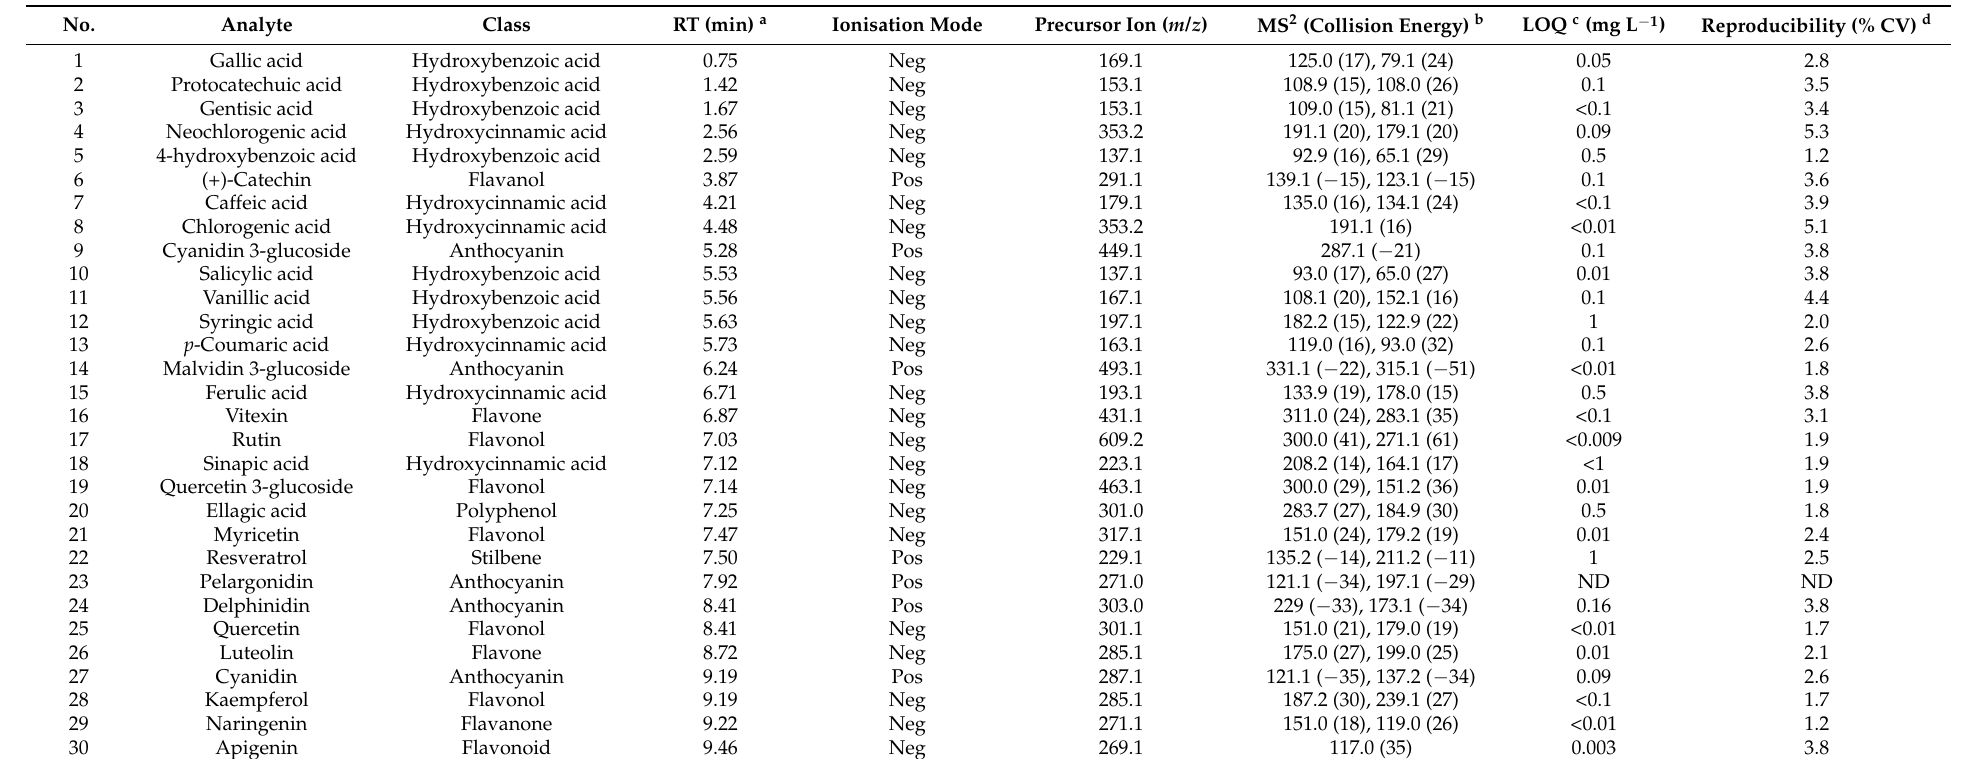
Table 3. Analytical parameters of the LC-MS/MS